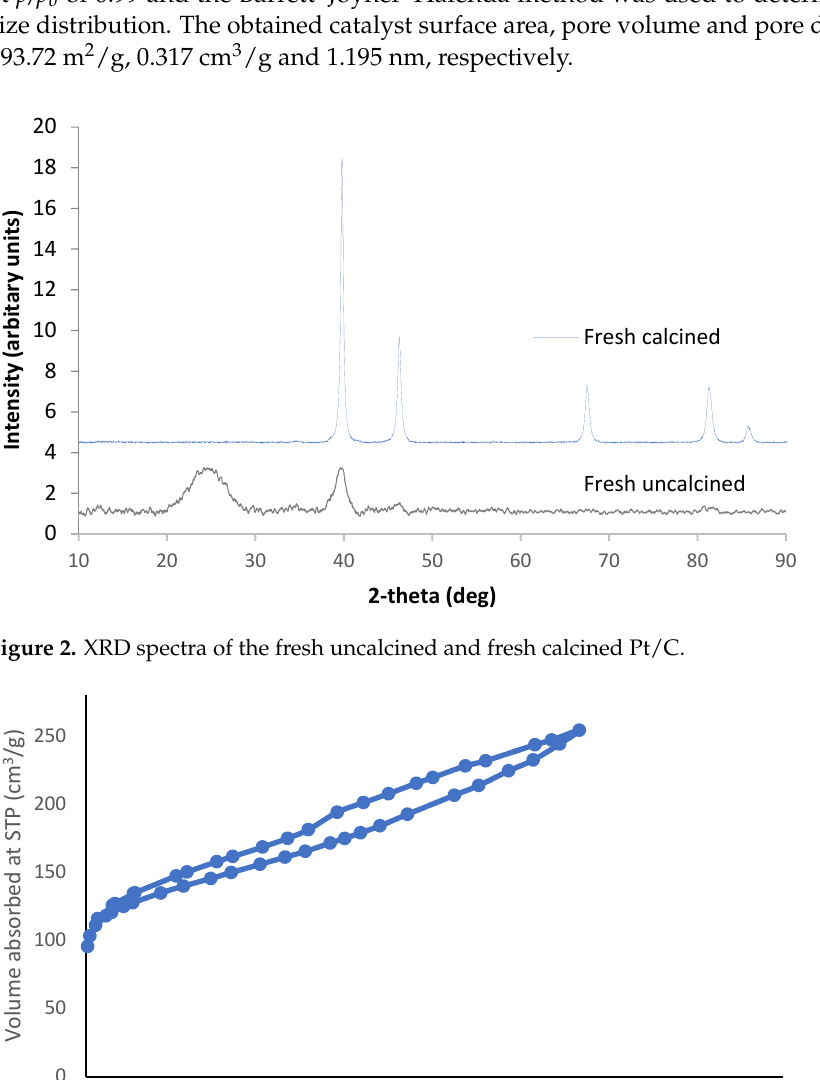
Table 2. Effect of temperature on the butyric acid conversion and gas yields from reaction times of 0 and 1 h.